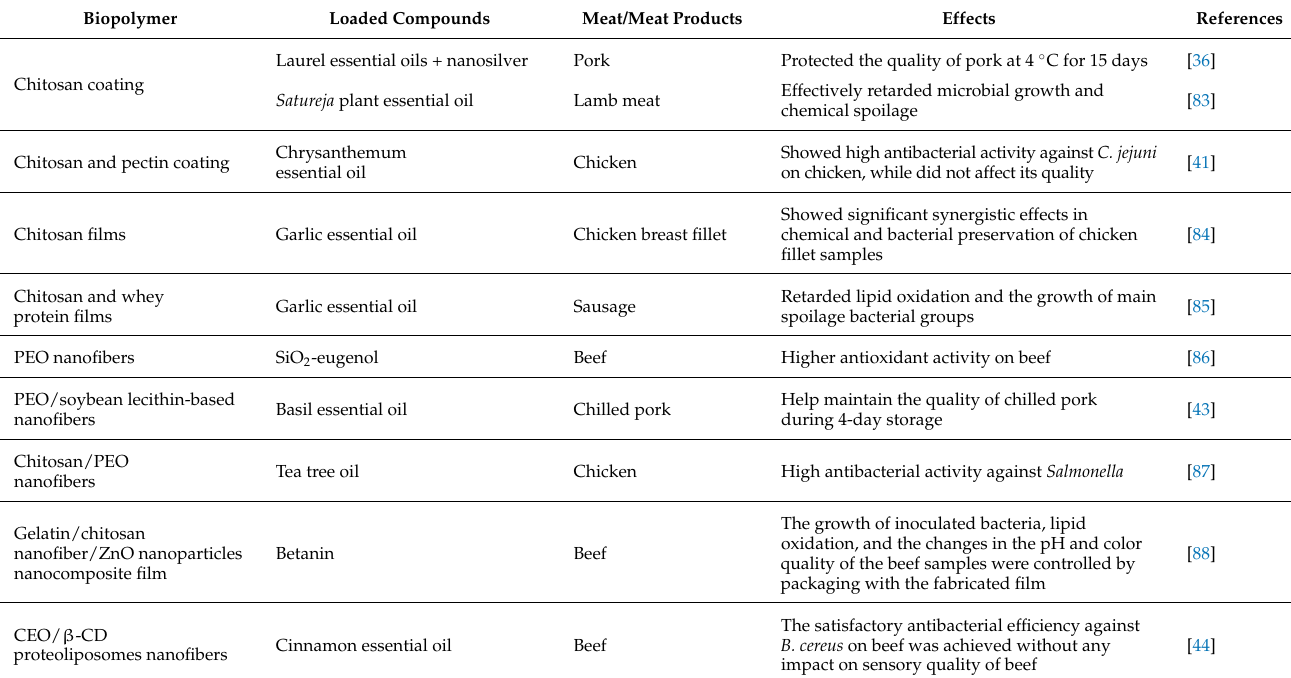
Table 3. Applications of biopolymer-liposome hybrid systems in meat